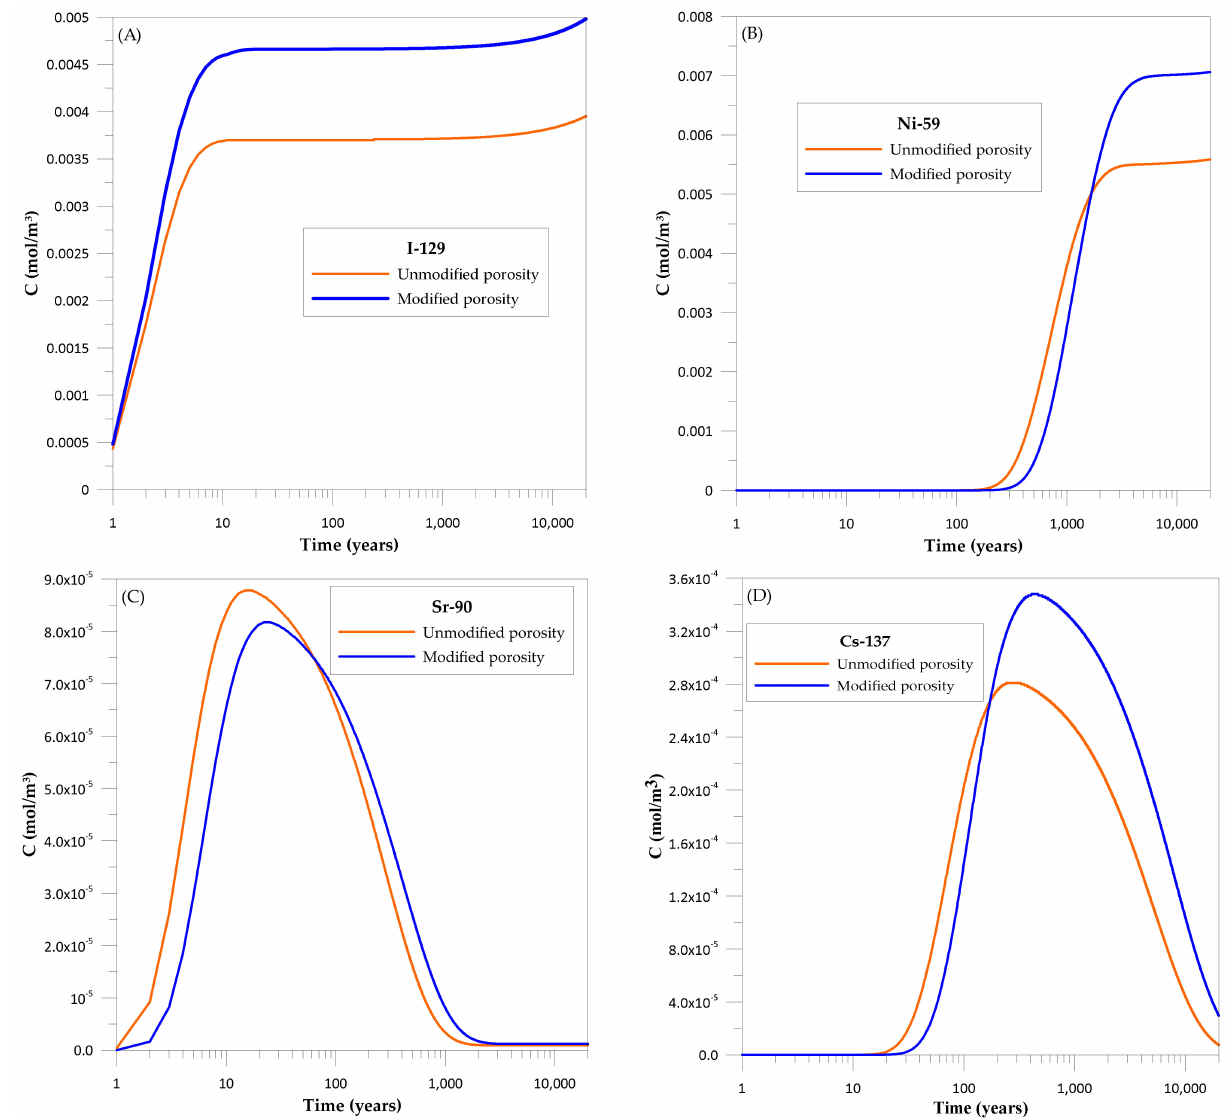
Figure 15. Concentration breakthrough curves as a function of time for radionuclides with and without porosity correction: ( A ) I-129; ( B ) Ni-59; ( C ) Sr-90; ( D )